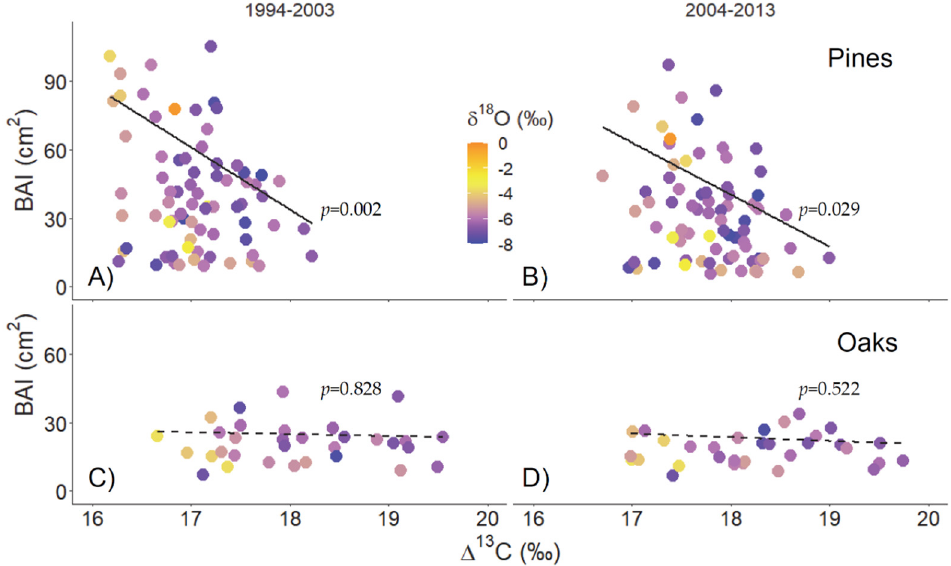
Figure 5. Quantile regressions between Δ 13 C and BAI during a wet (1994-2003; left panels) and a dry decade (2004-2013; right panels). ( A , B ) Pines; ( C , D ) oaks. The lines indicate 0.75 quantile regressions, including p -values of the slope coefficient. Significant regressions are shown with continuous lines, non-significant regressions with dashed lines. Color ramp of the dots denotes δ 18 O values of xylem water measured in November of 2011.